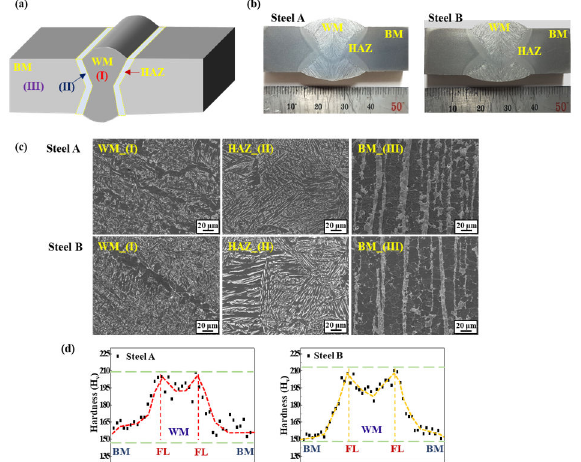
Figure 1. ( a ) Brief schematic diagram of the double-pass welded sample; ( b ) Cross-section view of the two welded samples; ( c ) Microstructures in the WM, HAZ, and BM of the two welded samples; ( d ) Vickers hardness profile of the two welded